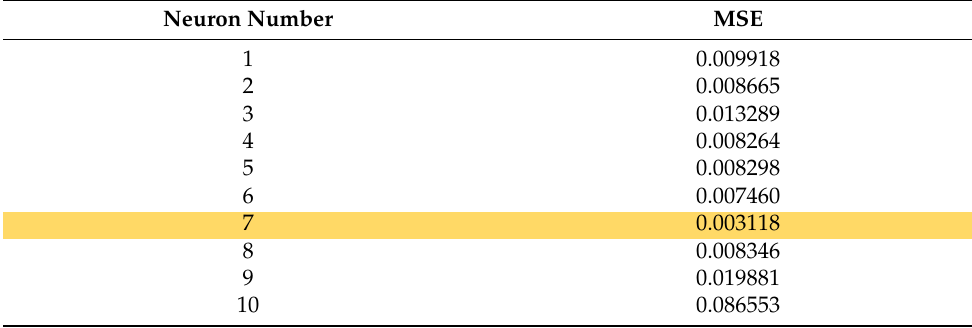
Table 13. MSE versus neurons in hidden layer for the NARX model.